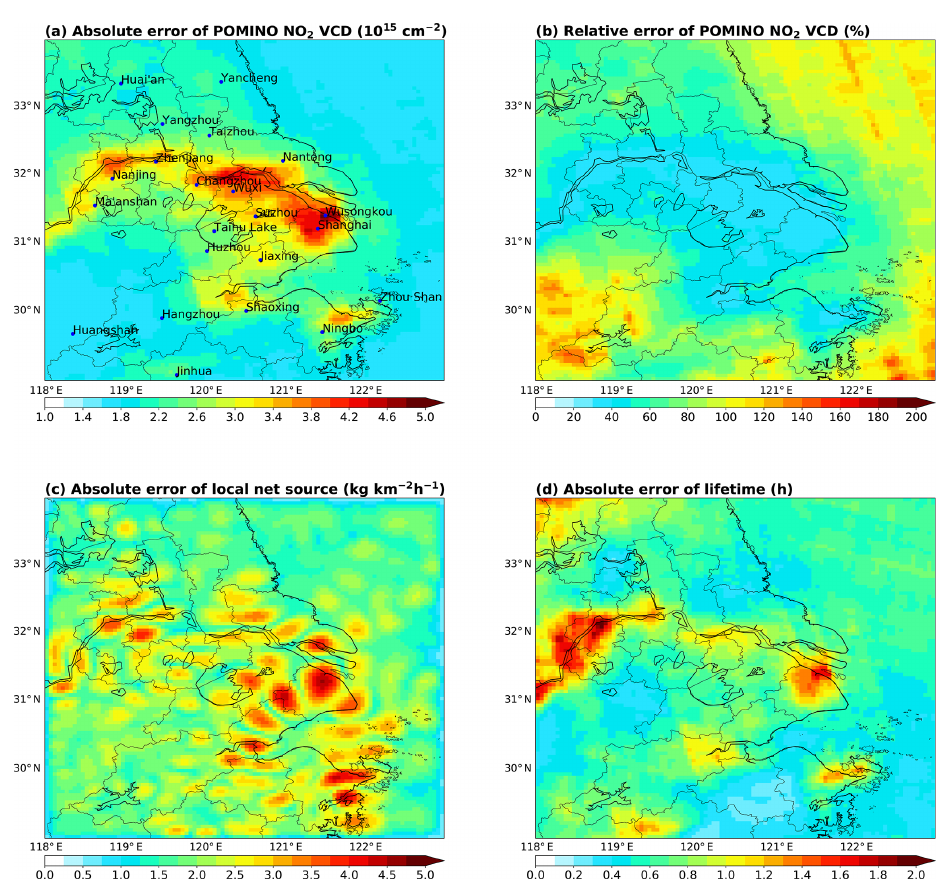
Figure 4. (a) Absolute error (1 σ ) of POMINO NO 2 VCD at each grid cell at the 0 . 05 ◦ × 0 . 05 ◦ resolution. (b) Relative error (1 σ ) of POMINO NO 2 VCD. (c) Absolute error (1 σ ) of the derived local net source. (d) Absolute error (1 σ ) of the derived NO x lifetime due to chemical loss and